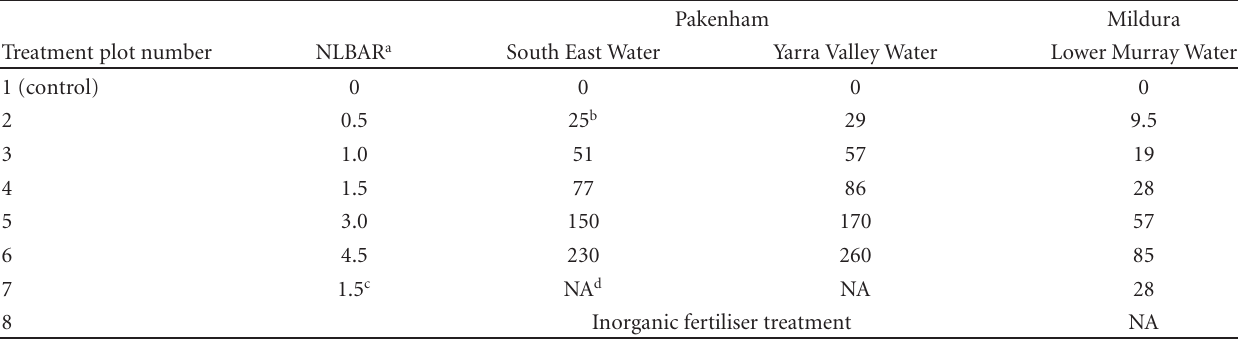
Table 3: Treatments, application rates (in terms of Nitrogen Limiting Biosolids Application Rate (NLBAR) and mass (dry tonnes/ha)) and source of biosolids used in trials at Pakenham and